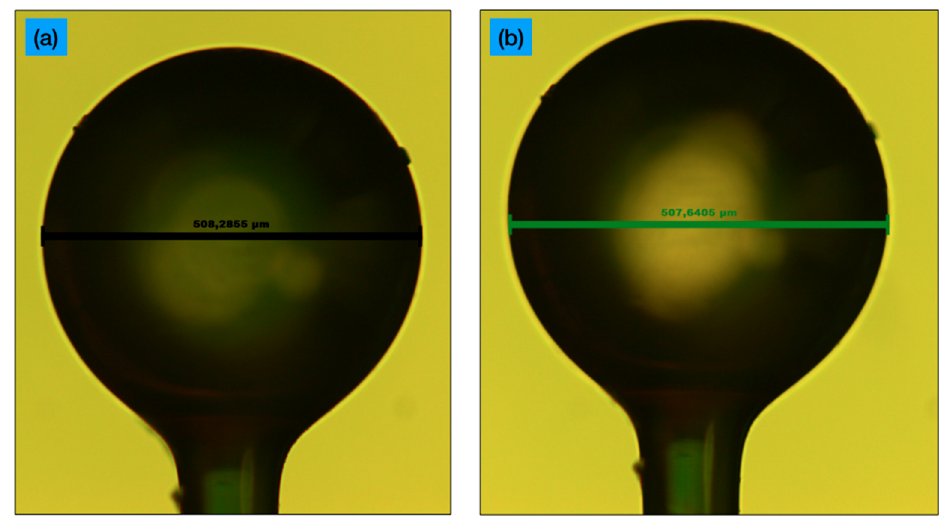
Figure 1. Photograph of the fabricated ball resonator under an optical microscope; ( a ) cross-section along the horizontal plane; ( b ) vertical plane.